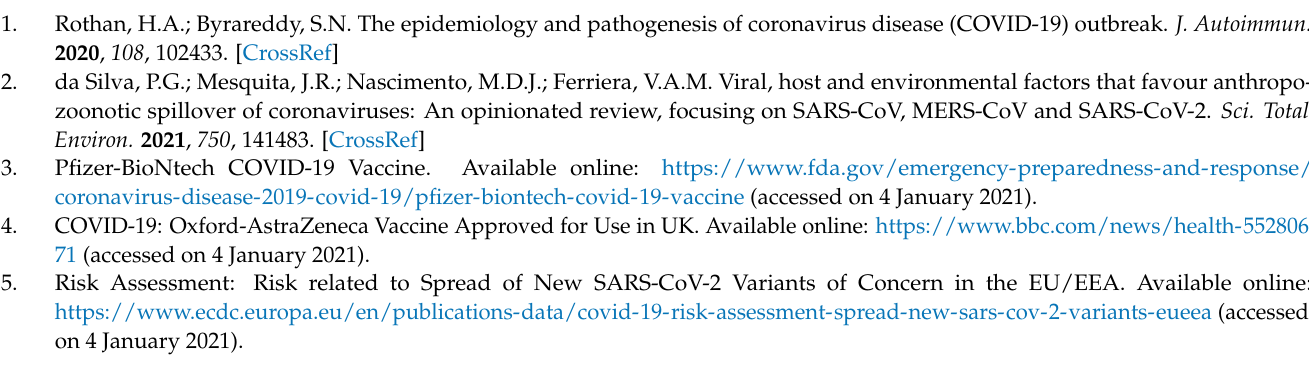
Supplementary Materials: The following are available online, Figure S1: Human coronavirus 229E (HCoV-229E) protective activity, Table S1: 1H and 13C NMR Data of butyrolactone I ( 1 ), Table S2: Table S4: 1H and 13C NMR Data of 4-hydroxy-3-(3-methylbut-2-enyl)benzaldehyde ( 4